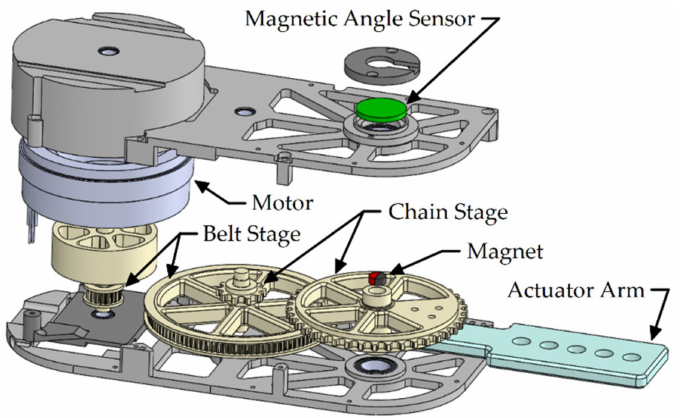
Figure 1. Exploded view of the joint actuator design for the pediatric